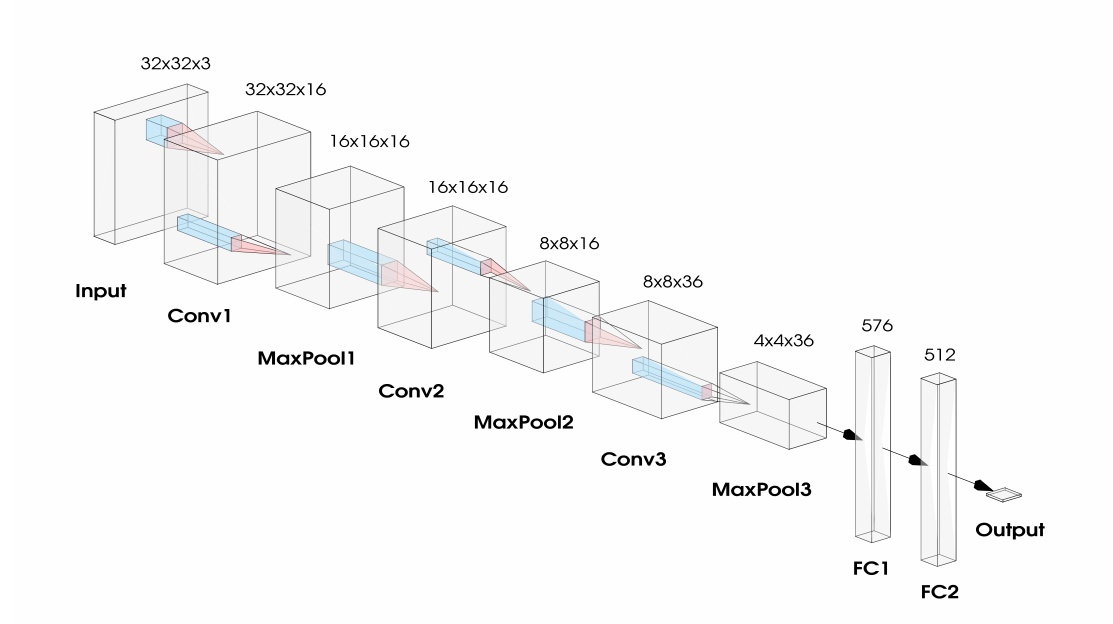
Figure 1. Proposed model architecture of Dilated CNN depicting the various Convolutional, Pooling, Flatten and Dense layers along with the shapes of their respective input and output tensors. The Input consists of a single image of shape 32 × 32 with 3 channels for colors RGB. Figure generated using NN-SVG